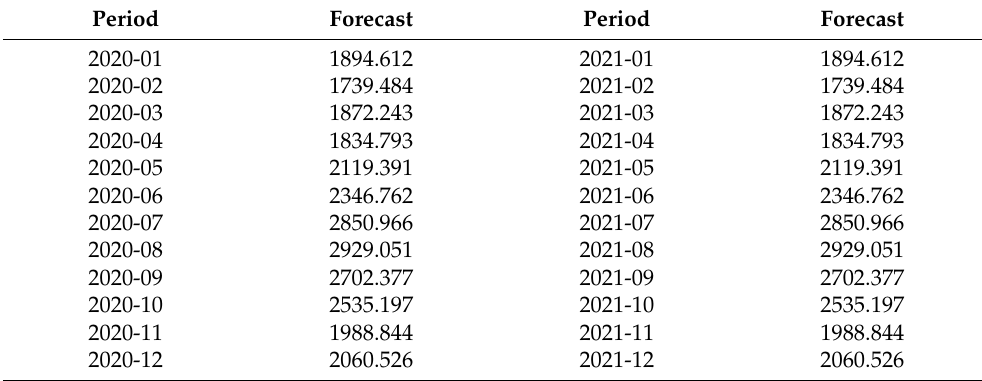
Figure 3. Exponential smoothing of kerosene-type jet fuel supplies. Source: own elaboration. The values of the forecasts obtained on the basis of this are presented in Table 1, and the forecast errors are in Table 2. Table 1. Monthly kerosene-type jet fuel supply forecasts for 2020–2021 (in thousands of tones). Source: own elaboration.